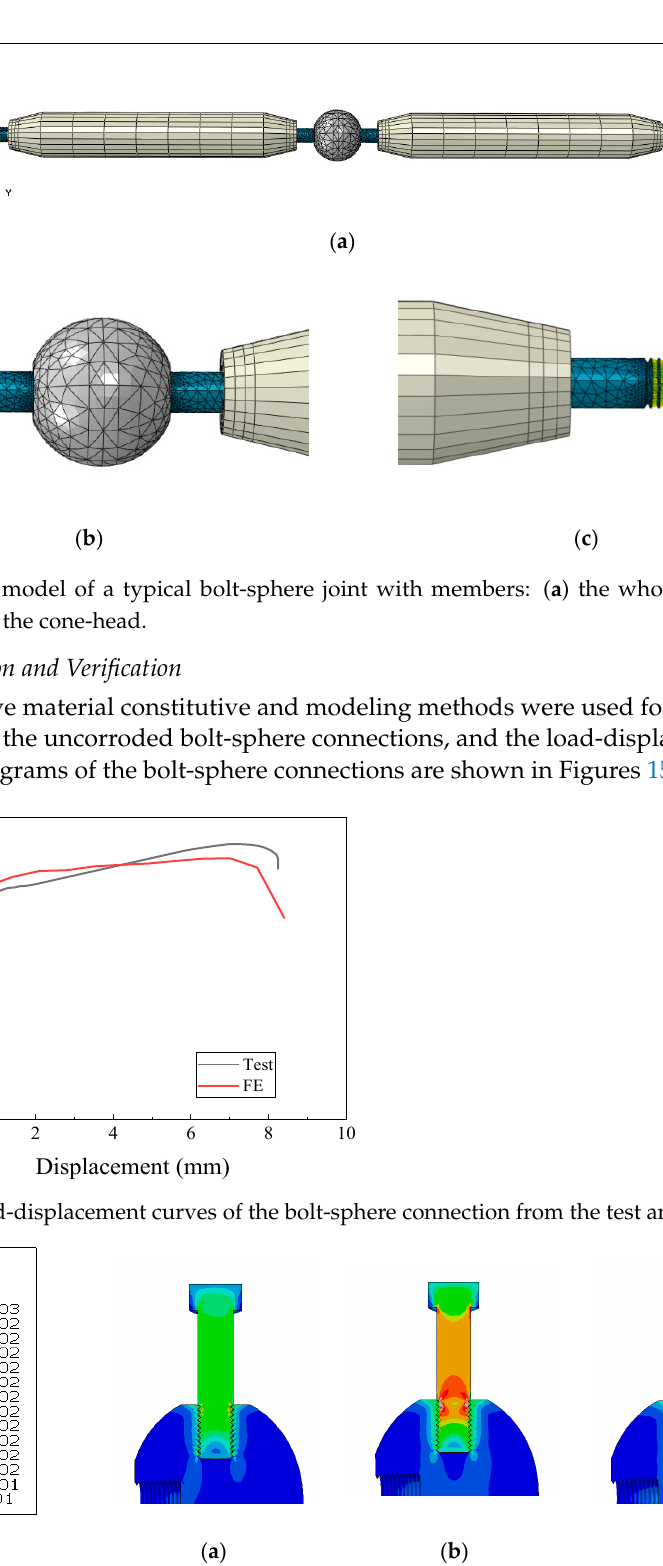
Figure 13. FE model of a typical bolt-sphere connection: ( a ) the whole model; ( b ) the bolt; ( c ) bolt hole.